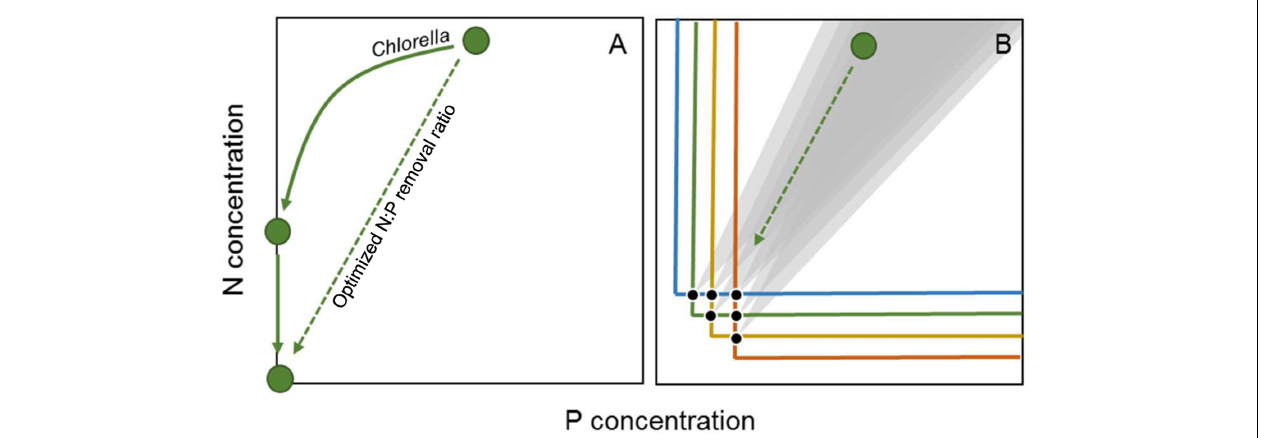
FIGURE 2 | Schematic representation of current N and P removal with Chlorella (A) and expected removal with multiple species in a continuous culture system (B) , where horizontal and vertical lines indicate zero net growth isoclines or R ∗ values, with colors denoting different species and the black circles indicating equilibrium points where two species can coexist. The gray areas in (B) indicate hypothesized ranges in consumption vectors, or N:P uptake ratios, of species coexisting at the associated equilibrium point. The diagonal dashed arrows indicate an optimized higher N:P removal ratio.